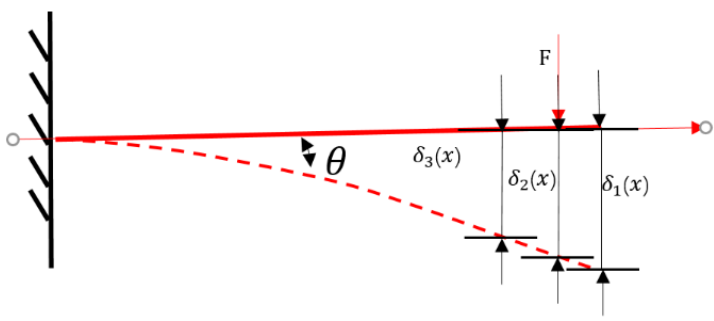
Under a cutting load, part of the edge of an end milling cutter has bending deflection and torsional deflection. The work of the cutting force is transformed into energy that is stored within the cutter, so that the cutter can perform external work. This energy is called elastic energy E ε . The cutting load is the main cause of tool bending deflection, as shown in Figure 2 [20,21]. If the tool is small, there is a bending moment and torque due to the cutting force. Because the deflections caused by these two internal force components are independent of one another, the total strain energy is equal to the sum of the strain energies when they act alone: where the strain energy E ε b is generated by the bending, and E ε n is produced by the torsion.